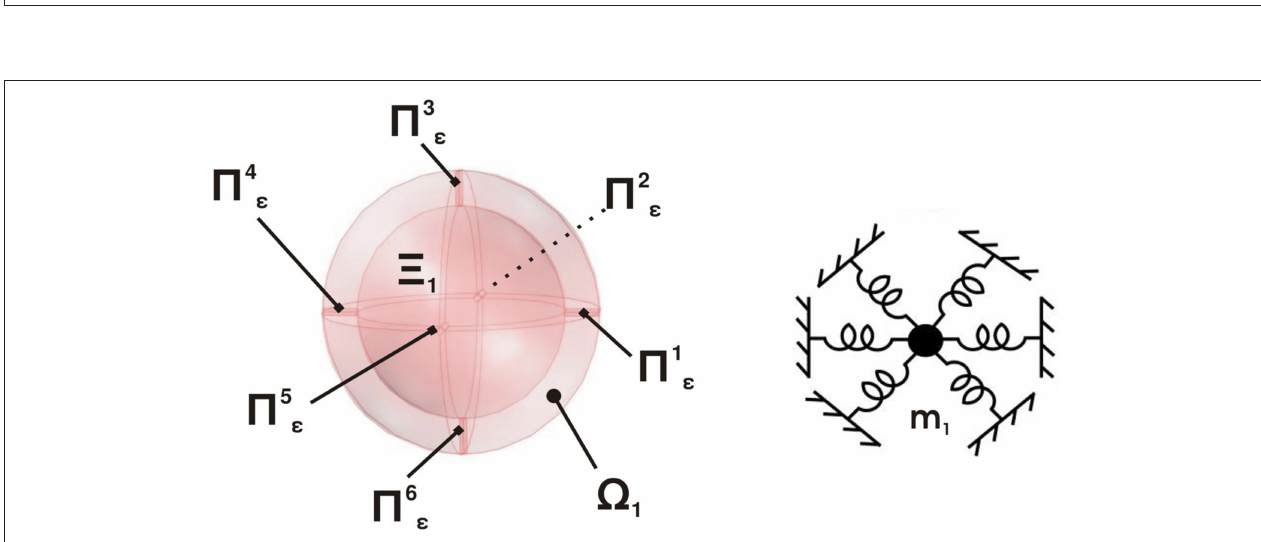
FIGURE 6 | Geometry of the inclusions and the Helmholtz oscillator consisting of six springs connected to a mass at one end and fixed at the other end.